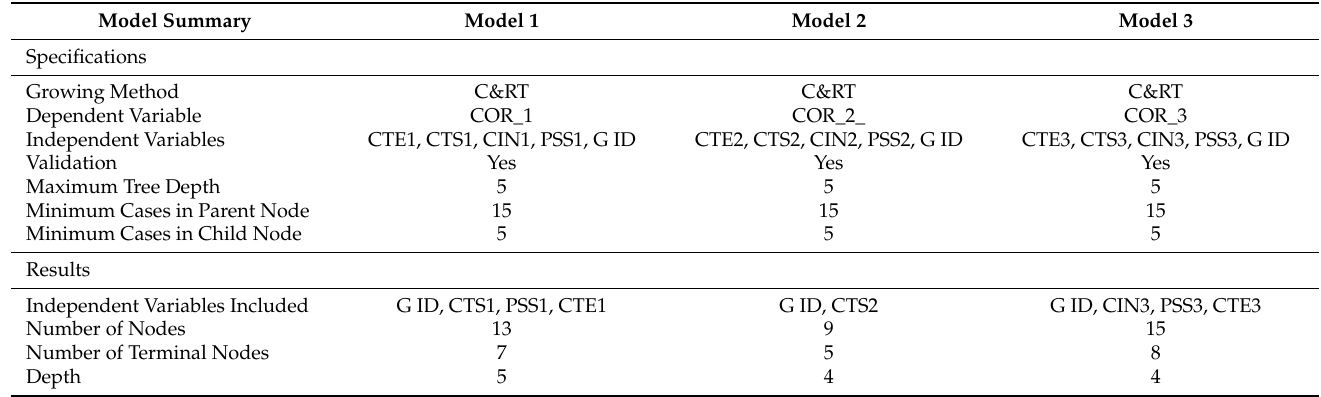
Table A2. Design description for the constructed decision tree models.